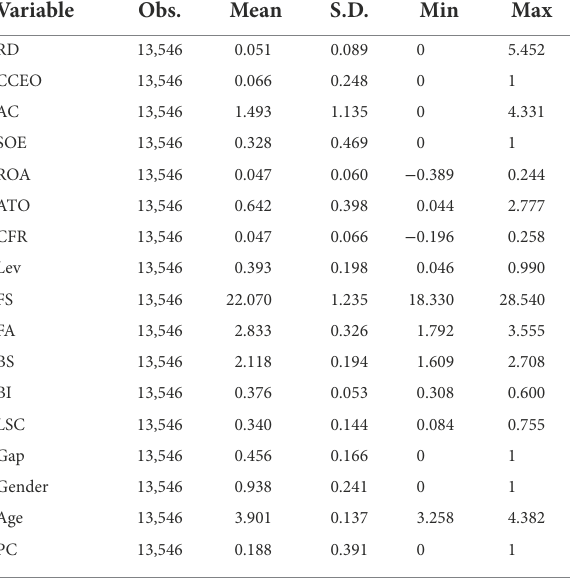
TABLE 2 Descriptive statistical results of variables.